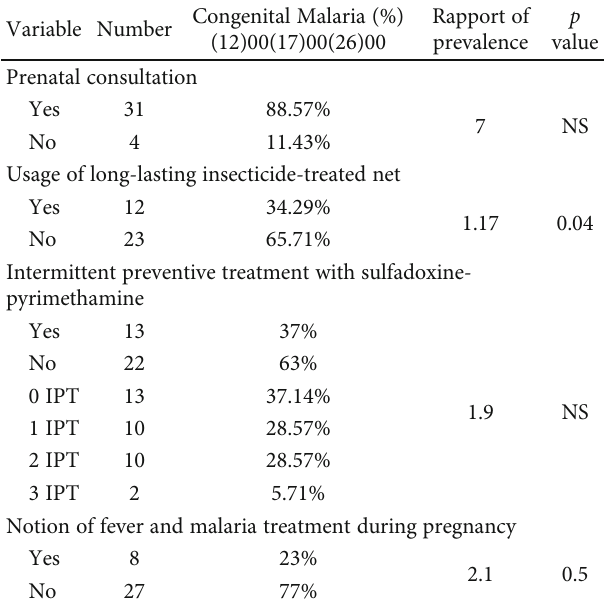
Table 2: Analysis of factors associated with congenital